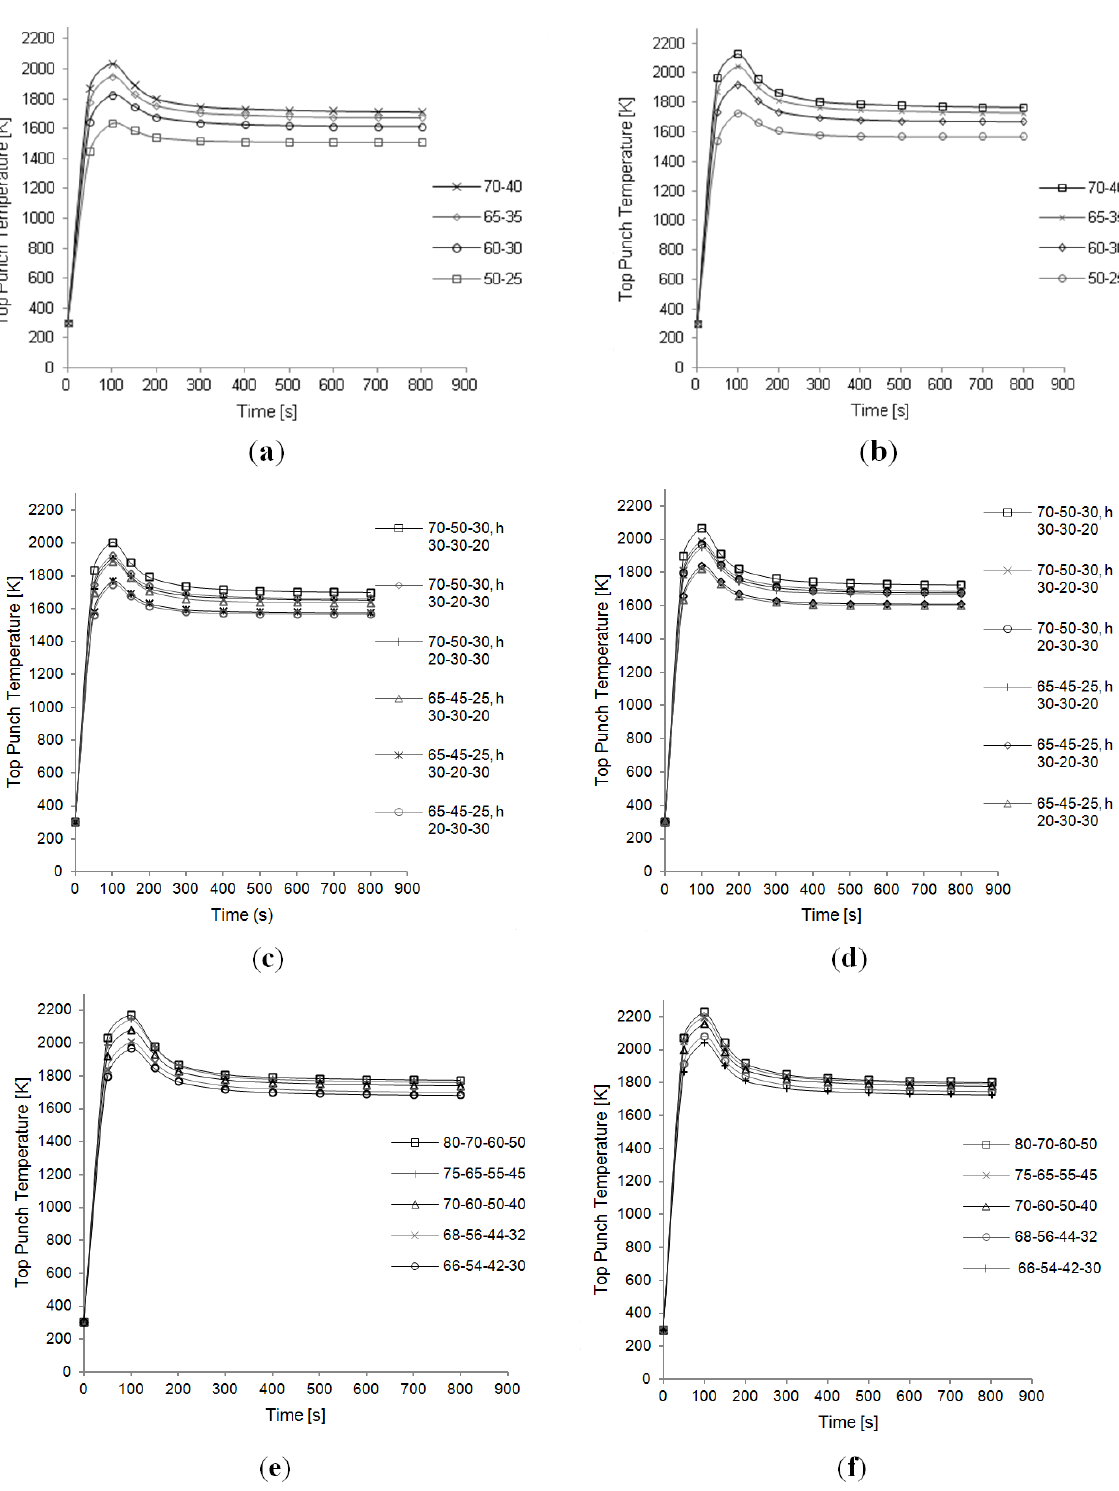
Figure 9. Temperature evolution in the top punch. ( a ) two disks setup—Ideal contact; ( b ) two transitional disks setup—Resistive contact; ( c ) three transitional disks setup—Ideal contact; ( d ) three transitional disks setup—Resistive contact; ( e ) four transitional disks setup—Ideal contact; ( f ) four transitional disks setup—Resistive contact. Dimensions of the setup are listed in the legend. The first three values correspond to disks radii, from top to bottom; the last three values (marked by the letter “h”) indicate the respective